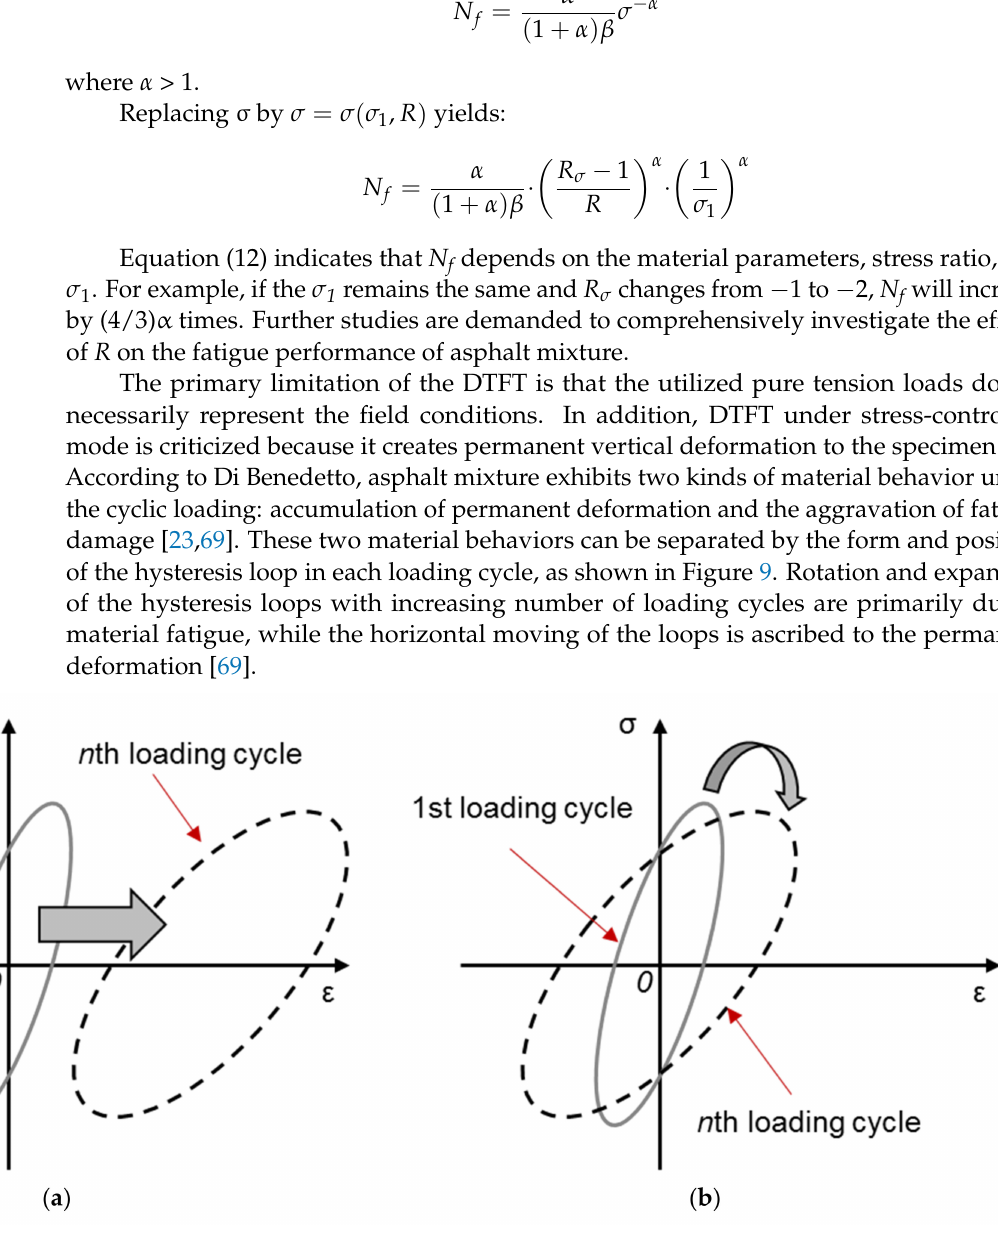
Figure 9. Changes in form and position of hysteresis loop. ( a ) Horizontal moving. ( b ) Rotation and